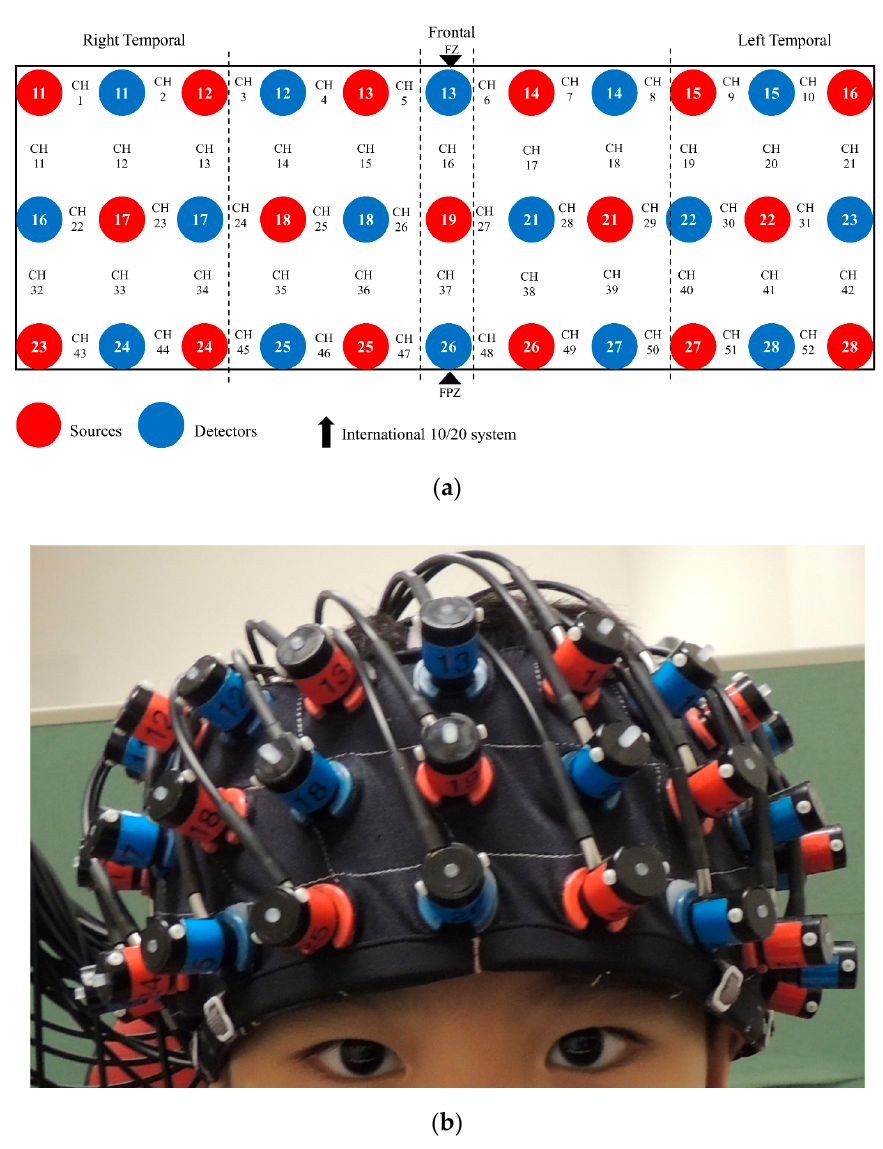
Figure 2. The 3 × 11 montage of the functional near-infrared spectroscopy (fNIRS) system: ( a ) 33 optodes and 52 channels (CH) arrangement; ( b ) placement on